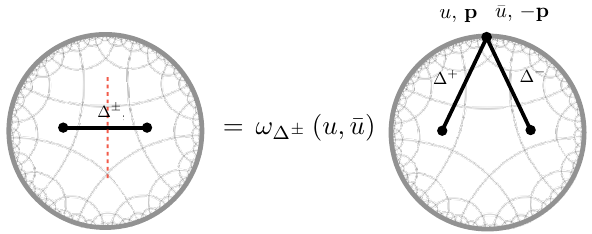
Figure 6. Diagrammatically we represent the discontinuity (2.33) of internal lines by a perpendicular red dashed line. The discontinuity of the ∆ ± bulk-to-bulk propagator in EAdS is factorised in u and ¯ u , which follows from the split representation of the harmonic function (2.26) and the factorised form of the projectors ω ( u, ¯ u ) ∆ ±